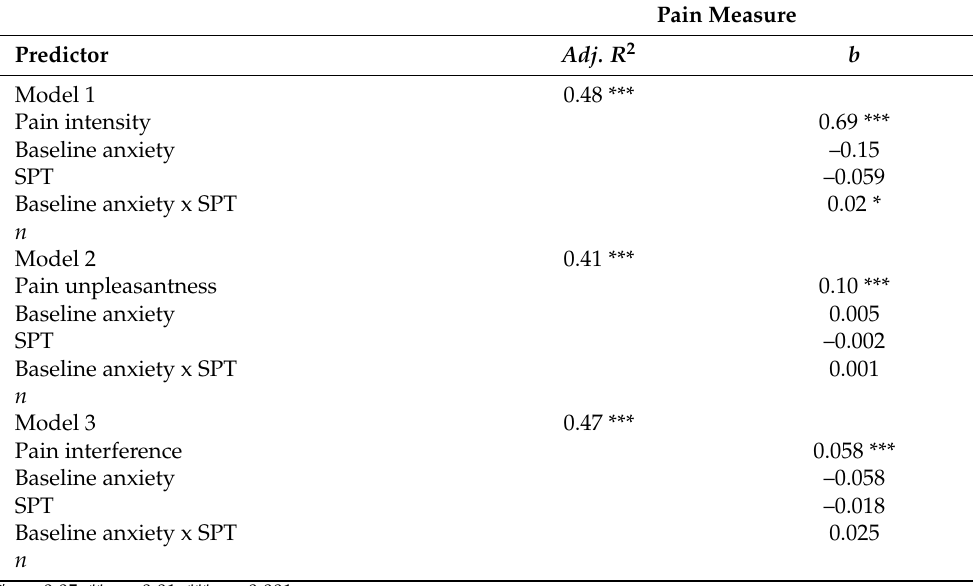
Table 4. Summary of multiple linear regression analyses for variables predicting pain